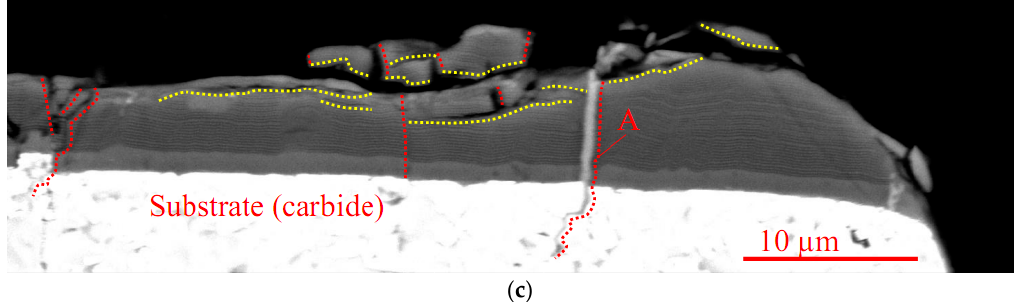
Figure 20. Mechanism of wear and failure for cutting tool with coating S5 ( a , b ) and S6 ( c ).